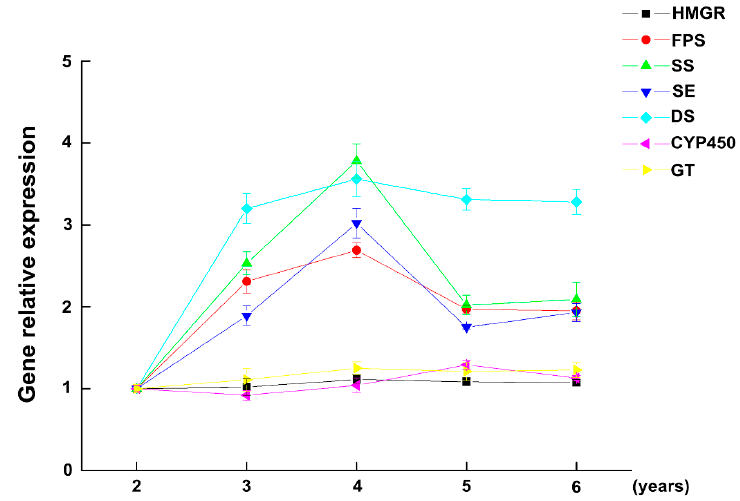
Figure 4. The changes in gene expression in fresh ginseng roots after different years of growth. (Gene expression at two years of growth was the control group, n = 60